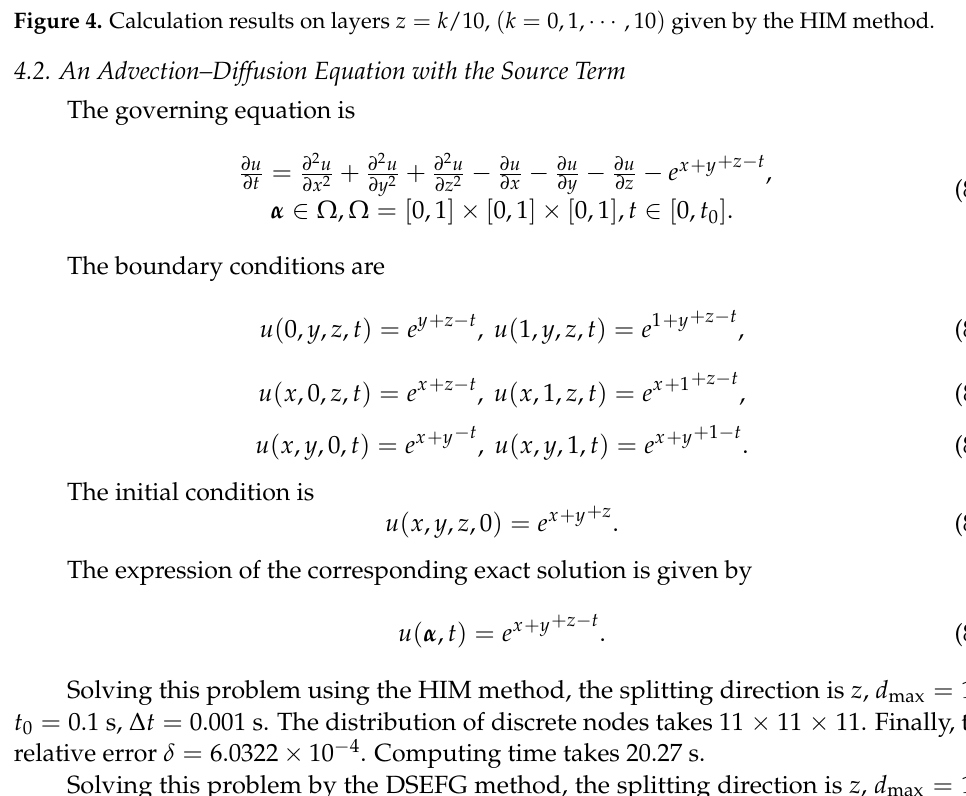
Figure 4. Calculation results on layers z = k /10, ( k = 0,1, · · · ,10 ) given by the HIM